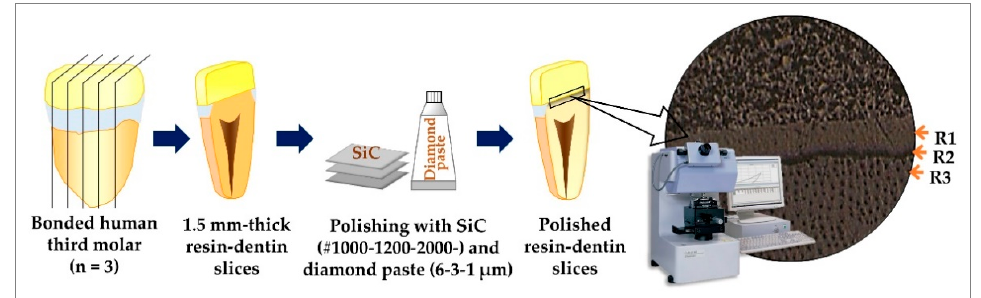
Figure 2. Schematic explaining the specimen preparation methodology and test set ‐ up for deter ‐ mining elastic modulus. The resin ‐ dentin interface was microscopically divided into three target regions—the adhesive layer ( R1 ), adhesive ‐ dentin interface ( R2 ), and sound dentin ( R3